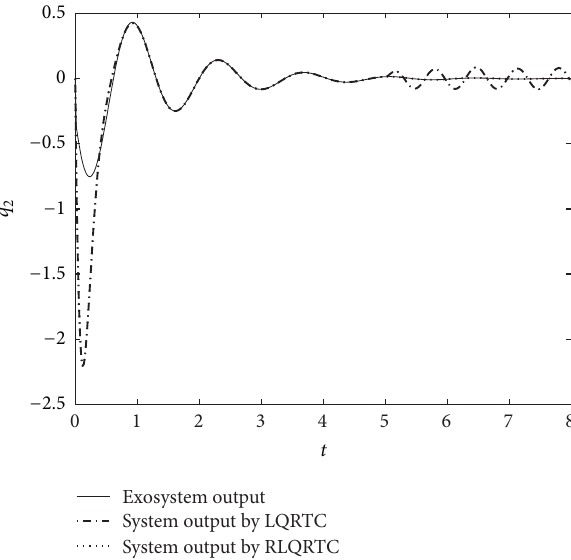
Figure 5: The tracking error 𝑒 4 (𝑡) of velocity ̇𝑞 2 for link 2.